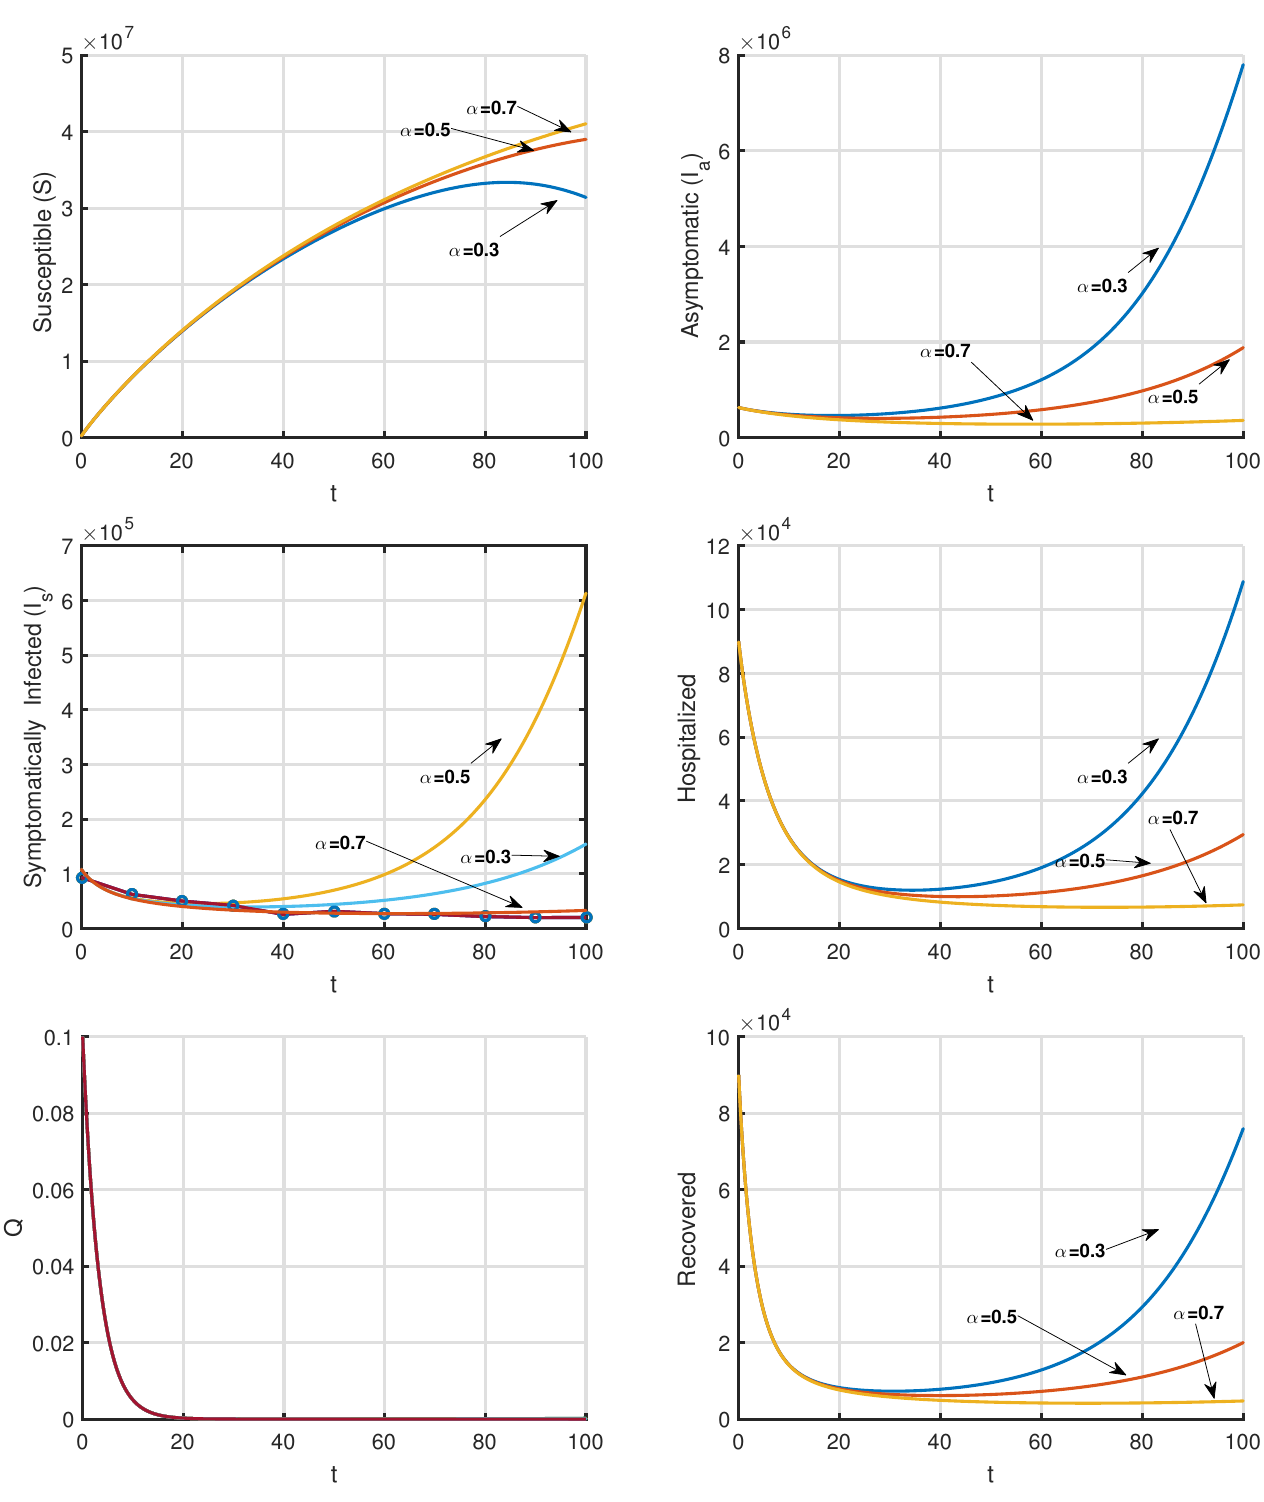
Figure 6. Variation time series with different values of α